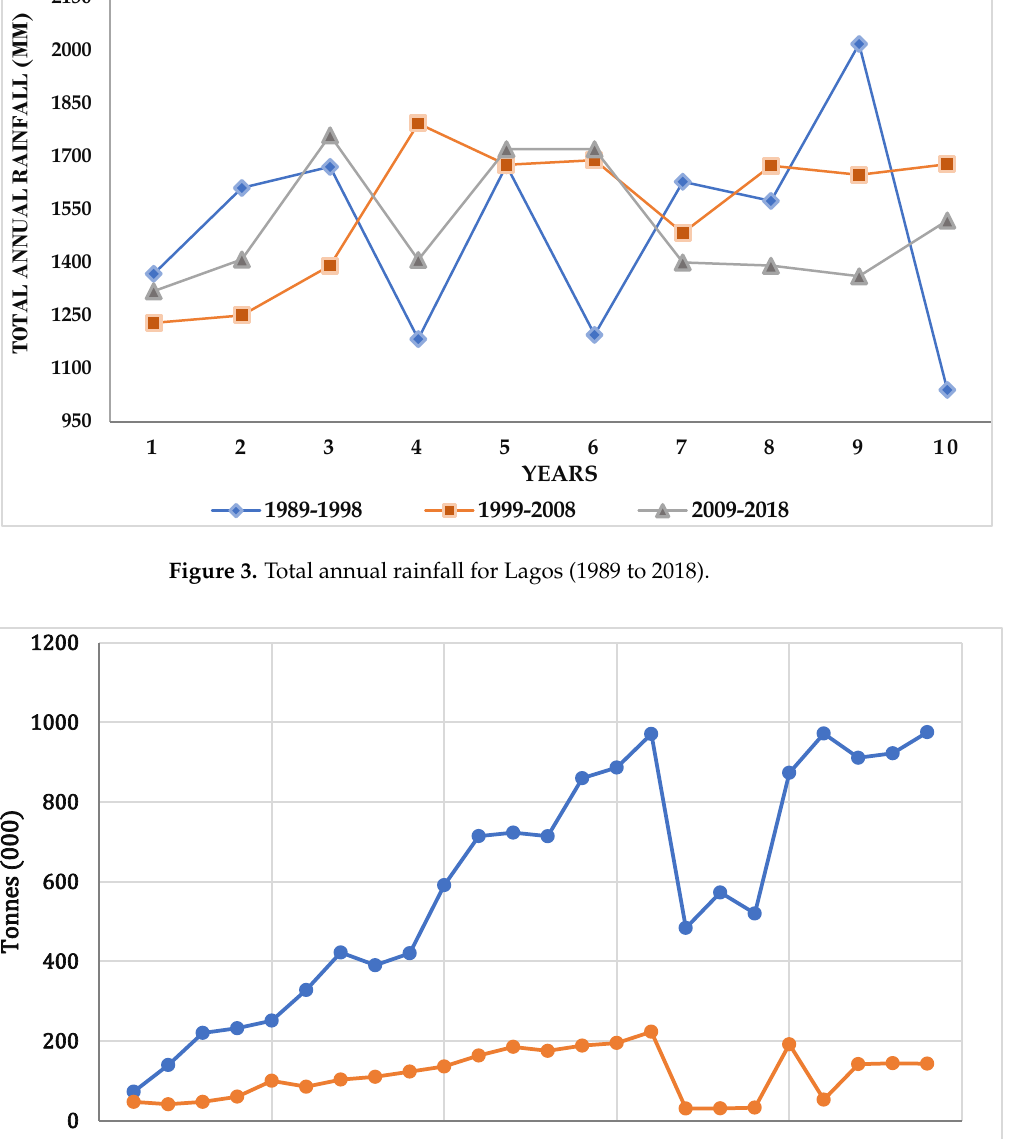
Figure 5. Lagos Cultivated land area for Cassava and Maize production through time (1995 – 2018).